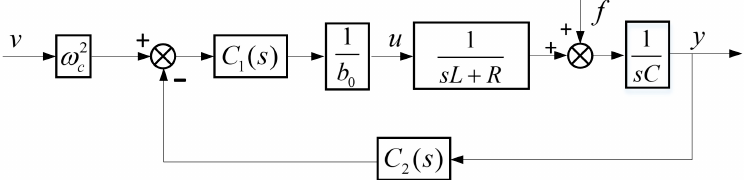
Figure 13. Block diagram of the wind power system controlled by new LADRC.